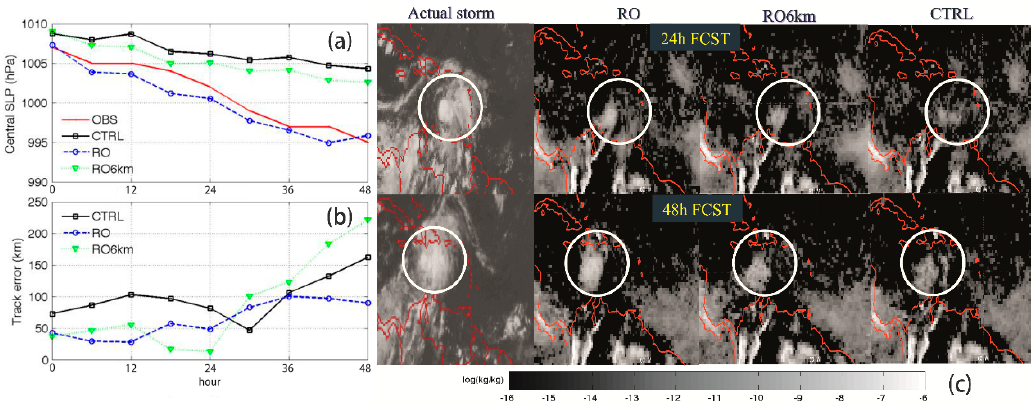
Figure 12. Forty-eight-hour prediction results of Storm Ernesto: ( a ) central sea level pressure; ( b ) track error; and ( c ) total column cloud liquid water obtained from three experiments and satellite infrared cloud image of the actual storm. The central sea level pressure (SLP) in the RO group is approximately 15 hPa lower than those in CTRL and RO6km, which makes the TC in RO stronger [61].